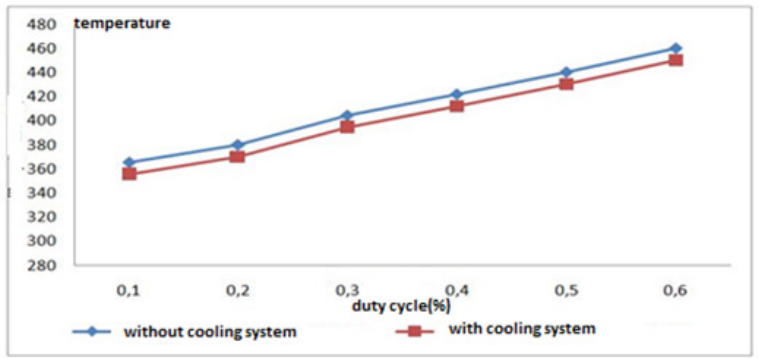
Figure 18. Evolution of the junction temperature in IGBT .